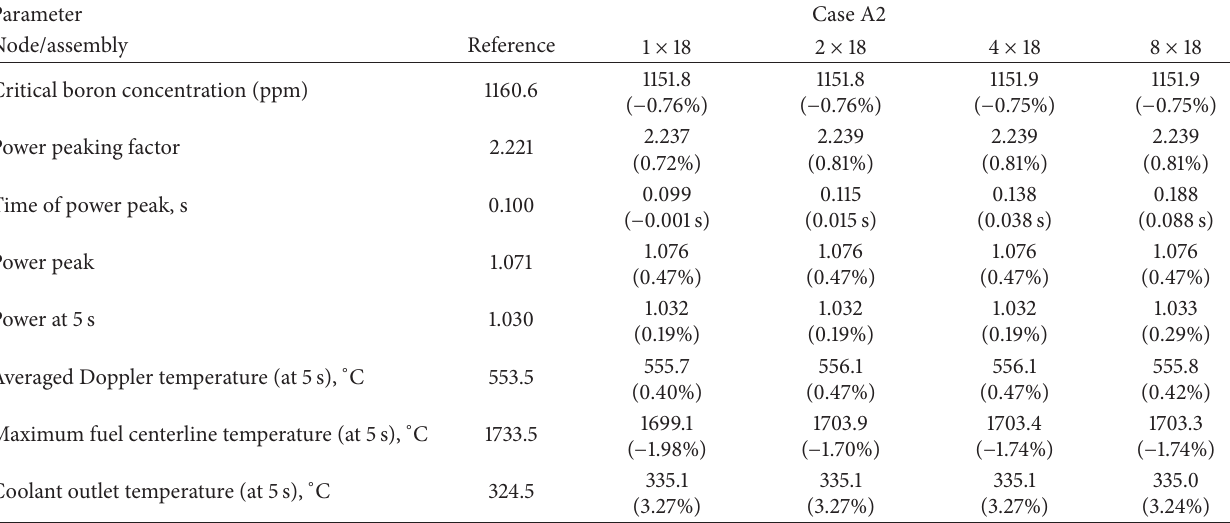
Table 4: Sensitivity analysis results in the axial node number per assembly for case A2.